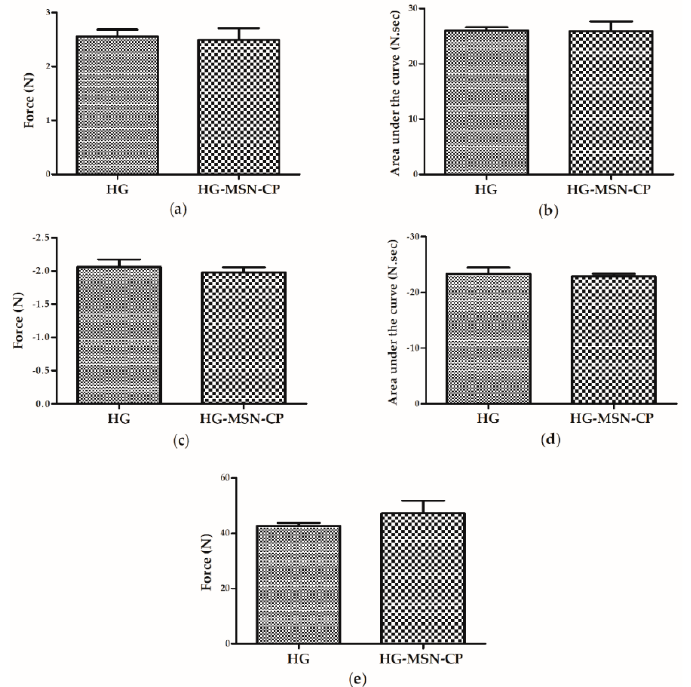
Figure 5. Texture properties of the hydrogel ( n = 3) with or without CP-loaded MSN (HG and HG- MSN-CP), using the backward extrusion test ( a – d ) and the forward extrusion test ( e ). ( a ) Firmness (backward extrusion); ( b ) Consistency; ( c ) Cohesiveness; ( d ) Index of Viscosity; and ( e ) Firmness (forward extrusion). Data are expressed as mean ± SD. Student’s t-test was used to compare the samples. No differences between the samples were observed.